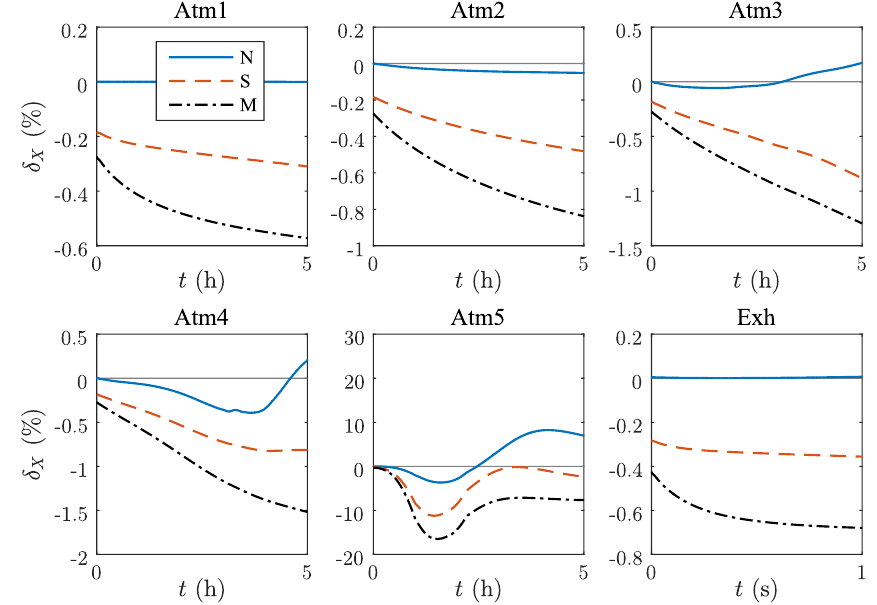
Figure 10. The relative errors of the moments ( δ X ) in the test cases produced by the PL + LN model. The input parameter sets are shown in